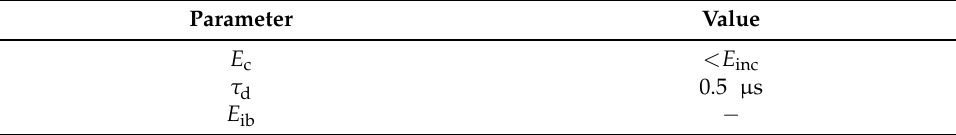
Table 4. Values of the input parameters required by Cooray’s